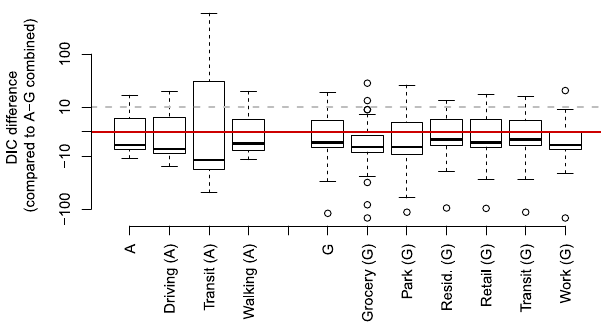
Fig. 5 Comparison of fi t between the individual data-streams and the Apple-Google data-stream used in the main results. Fit is assessed as the difference in DIC, a positive value (above the red horizontal line) indicates the individual data-stream could be favoured over the Apple-Google data- stream. The boxplot shows medians, interquartile ranges, ranges and outliers. Above the threshold of 10 highlighted with the dashed grey line, the individual data-stream would have substantially improved the fi t of the model. The y-axis is on a “ signed ” square root